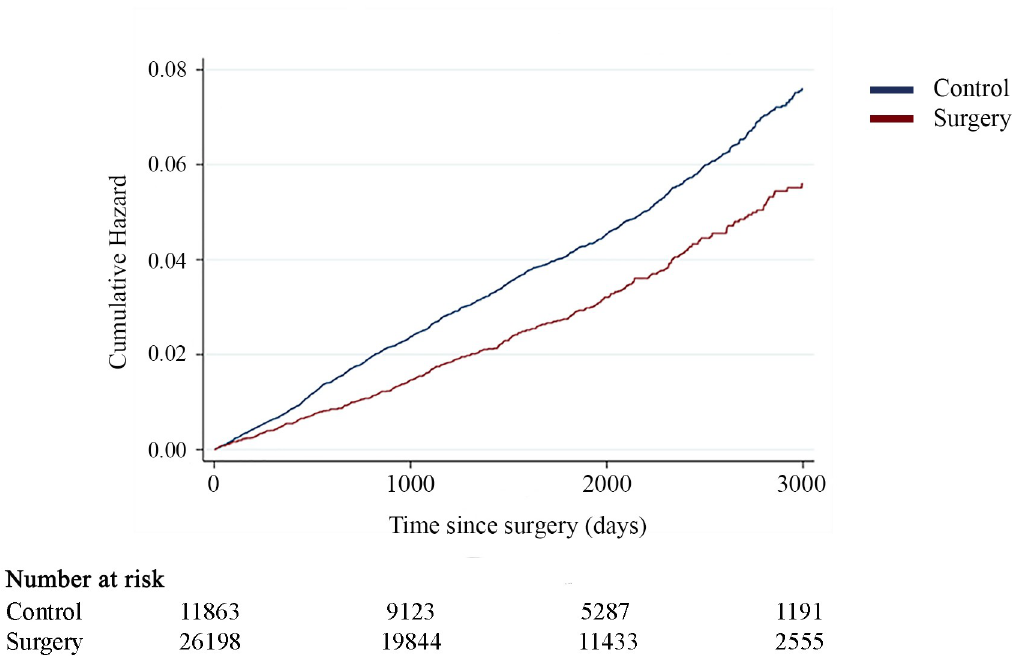
Fig 2. Cumulative hazard for MACEs. Cumulative hazard for an MACE comparing patients with hypertension operated on with metabolic surgery compared with a matched control group with hypertension from the general population (adjusted